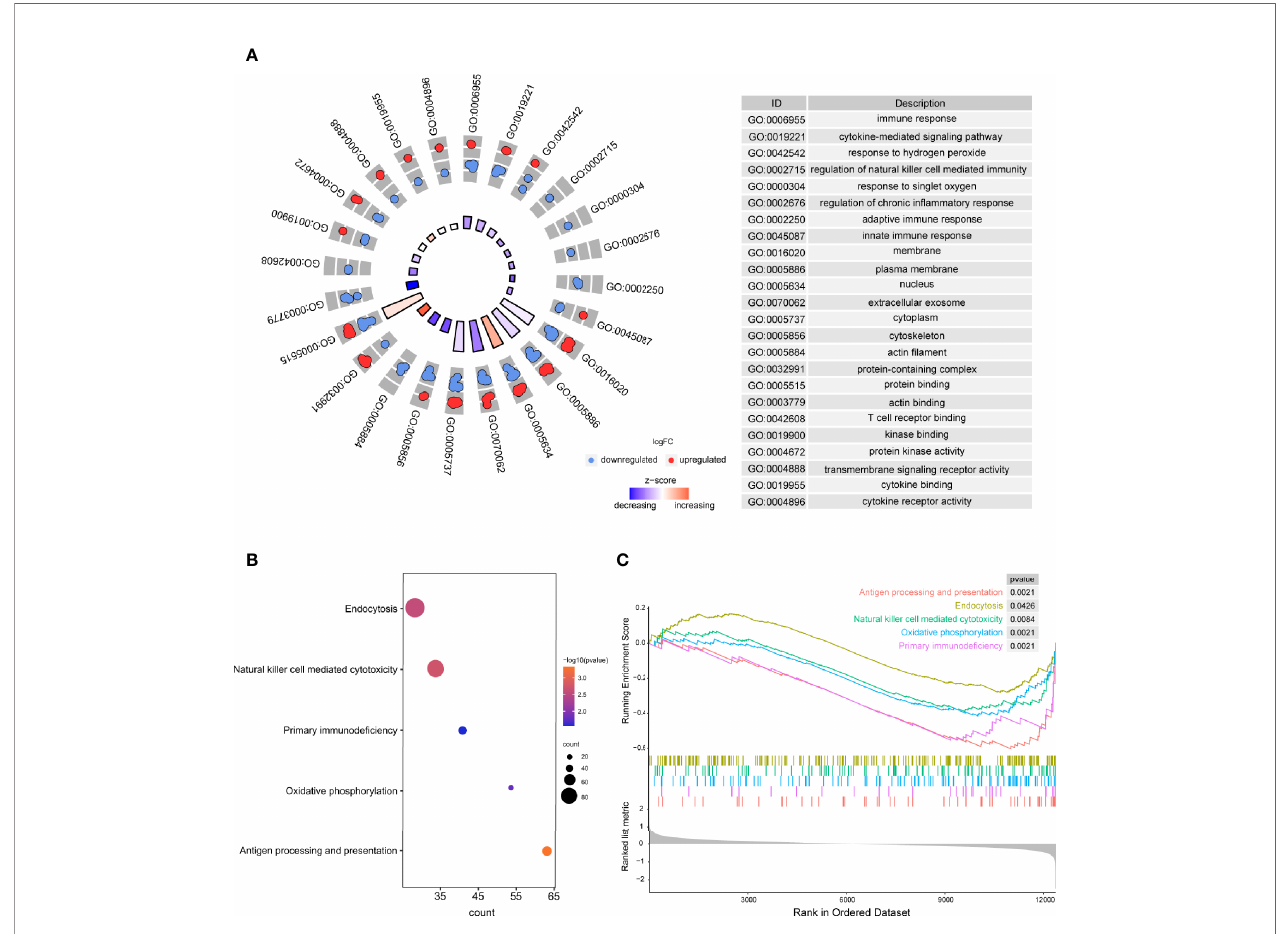
FIGURE 3 | The results of functional enrichment analyses. (A) GO analyses results of DEGs; (B) Pathway analysis results of DEGs; (C) GSEA pro fi les depicting the fi ve signi fi cant GSEA